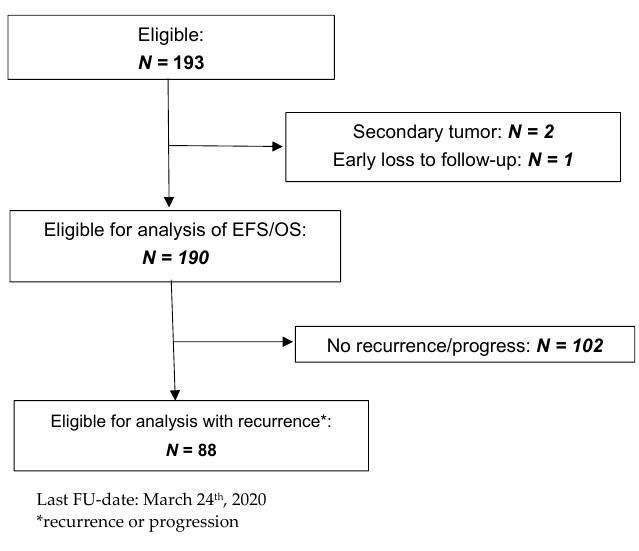
Figure 1. CONSORT diagram